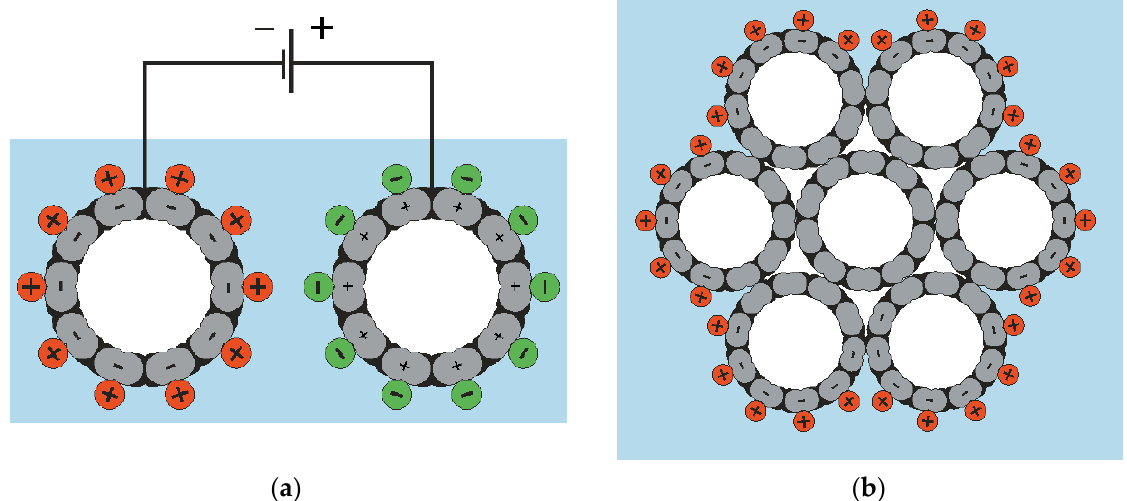
Figure 2. Electrostatic diagram of how one of the nanotube electrodes elongates and the other electrode constricts: ( a ) both electrodes are represented as individual nanotubes; ( b ) the electrode is represented as a bundle of nanotubes. Reproduced from [13] with permission from the American Association for the Advancement of Science. Copyright 1999.